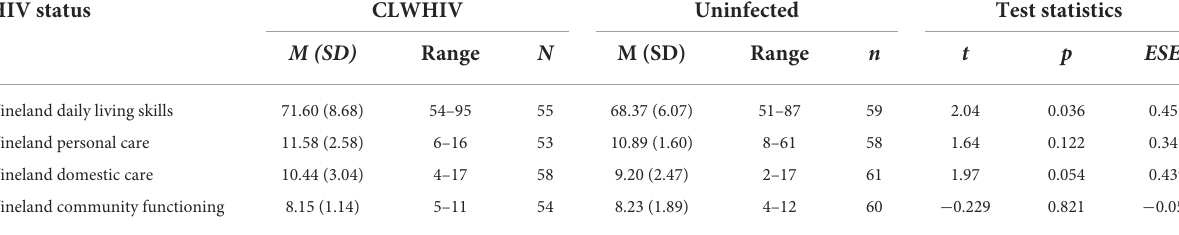
TABLE 4 Between group differences on the Vineland Adaptive Behavioral Scale: Daily living skills a .